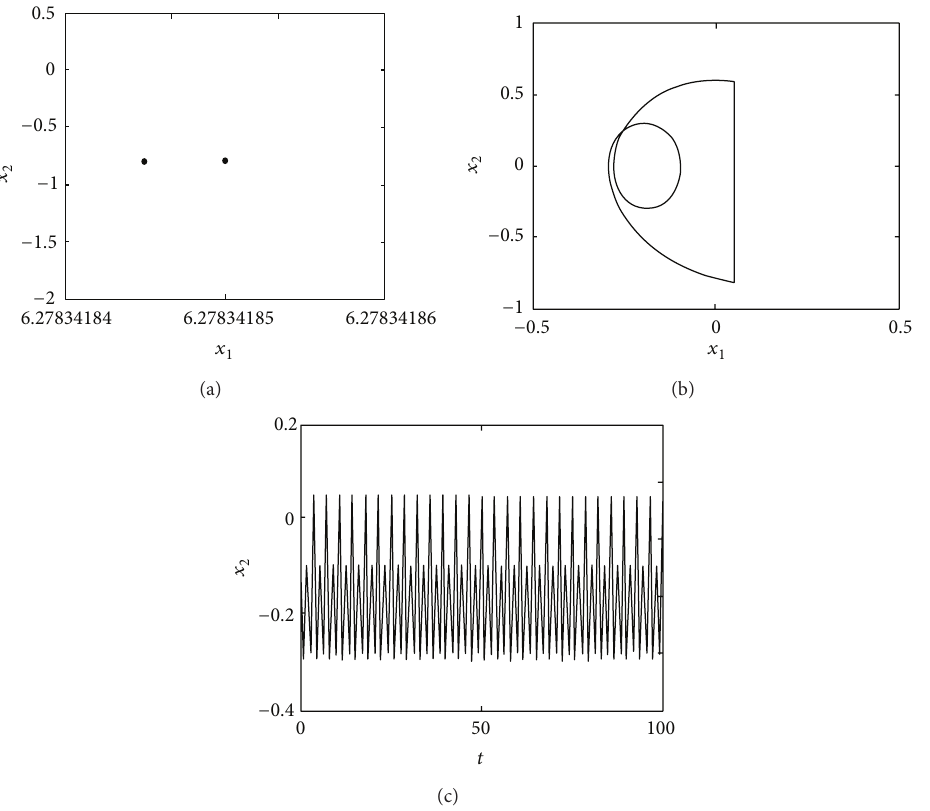
Figure 10: Poincar´e map, phase portrait, and time course diagram of the controlled system with 𝛾 = 0.05 and ℎ = 5.6